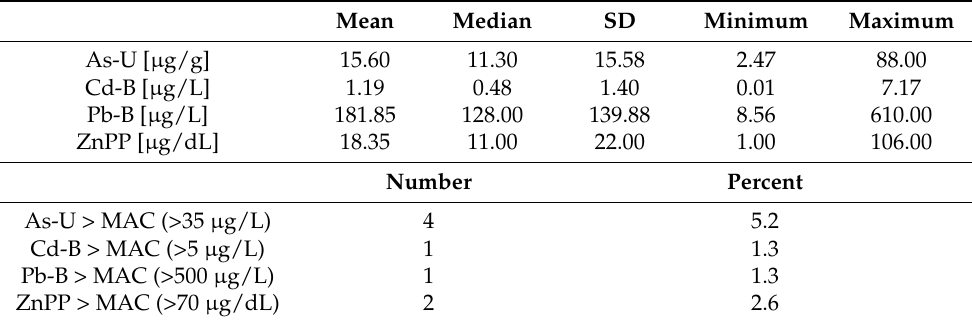
Table 2. Basic toxicological parameters in the study